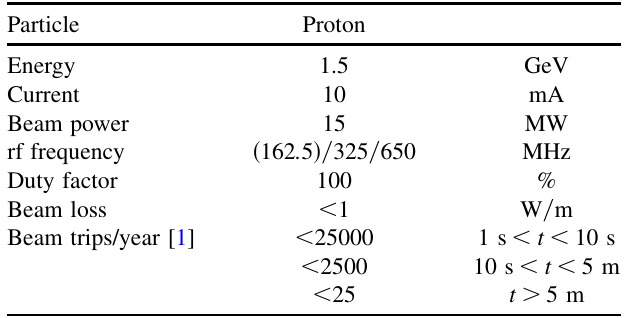
TABLE I. Specifications of the required proton beam for